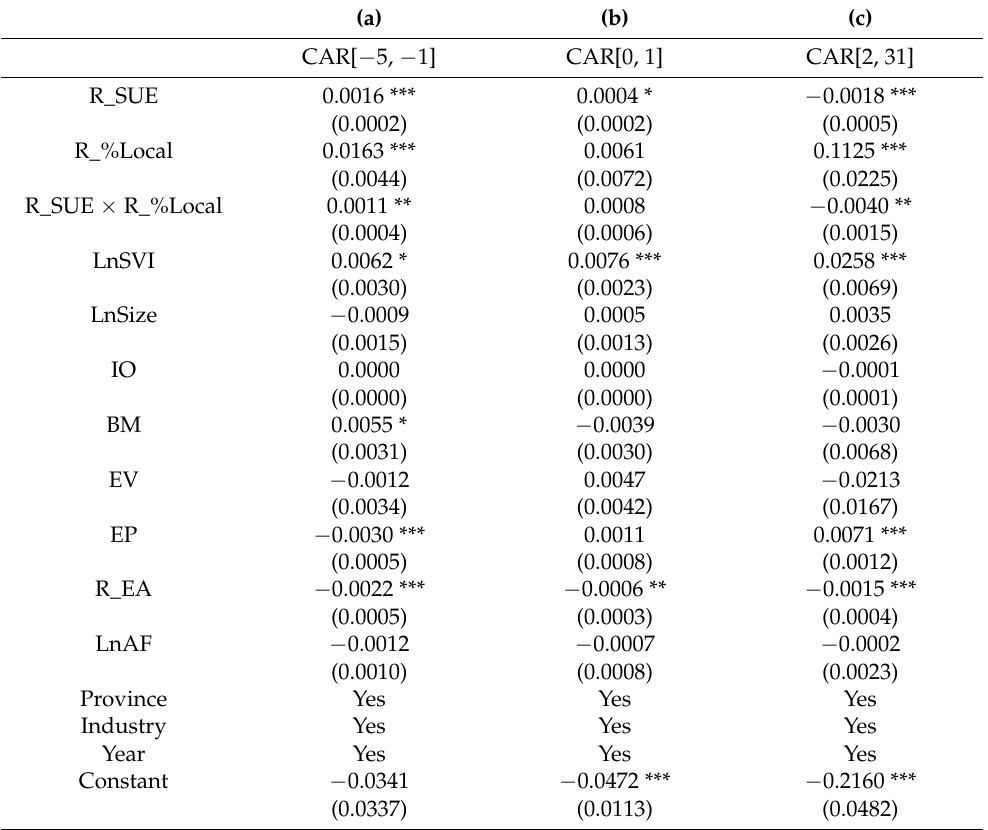
Table 10. Second-Stage Regression Results of Cumulative Abnormal